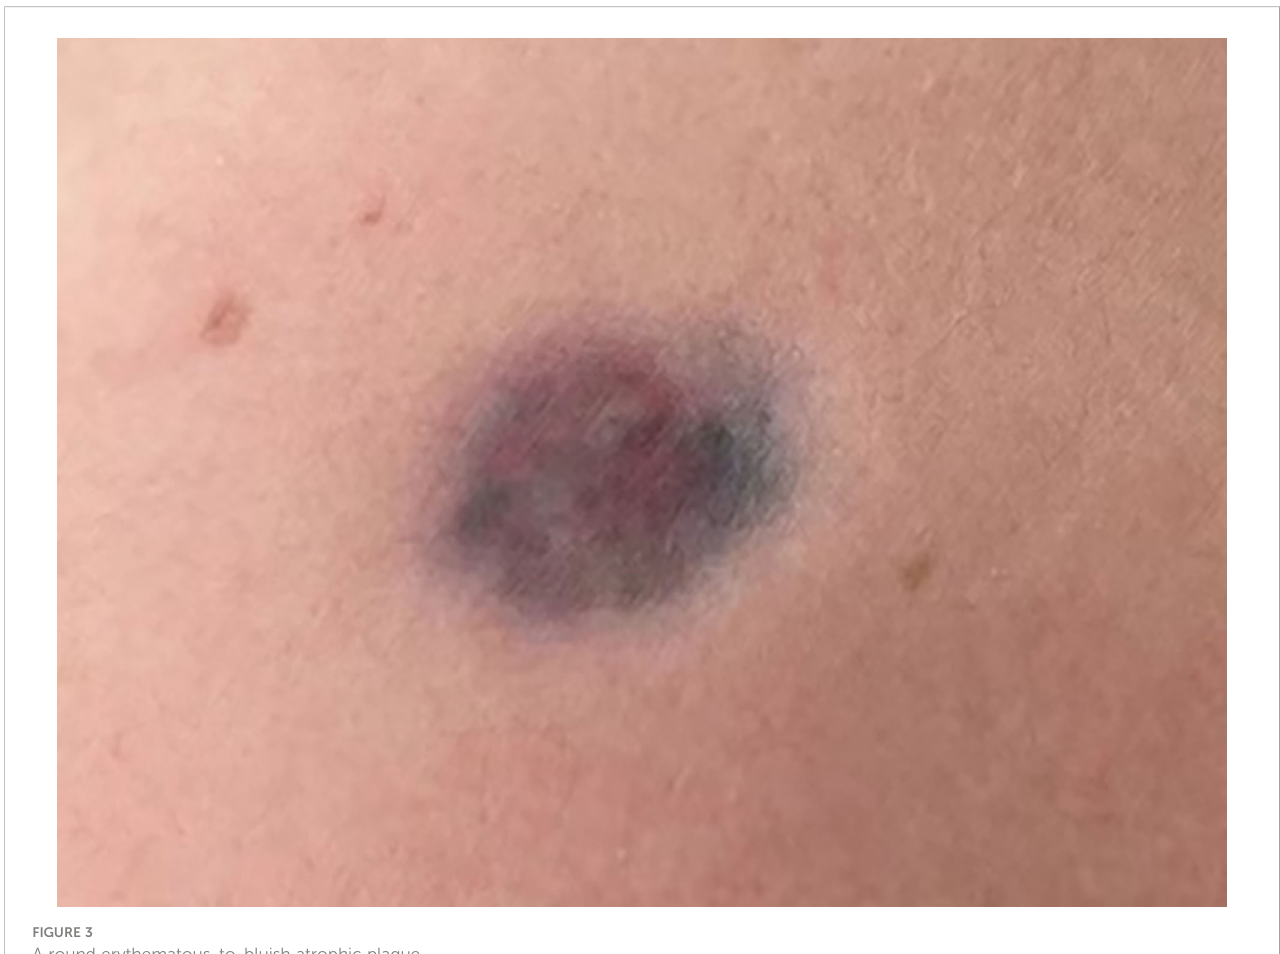
FIGURE 3 A round erythematous-to-bluish atrophic plaque.